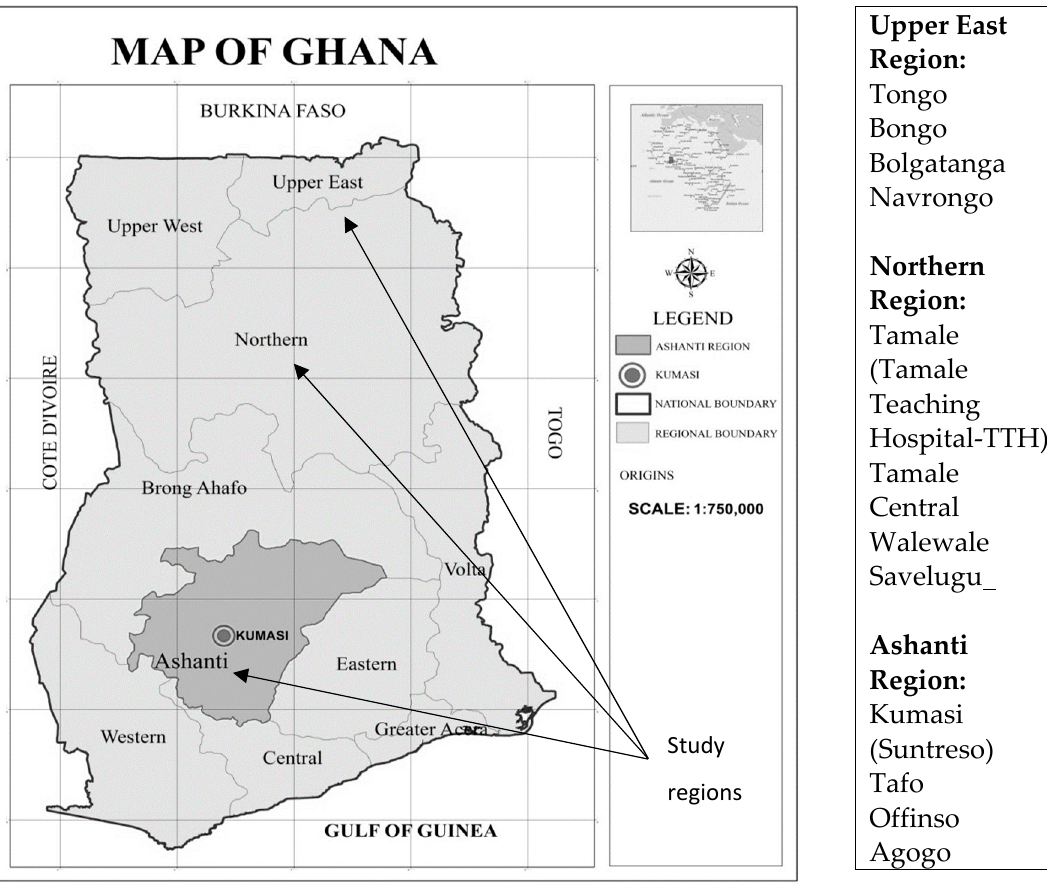
Figure 1. Map of the study area.